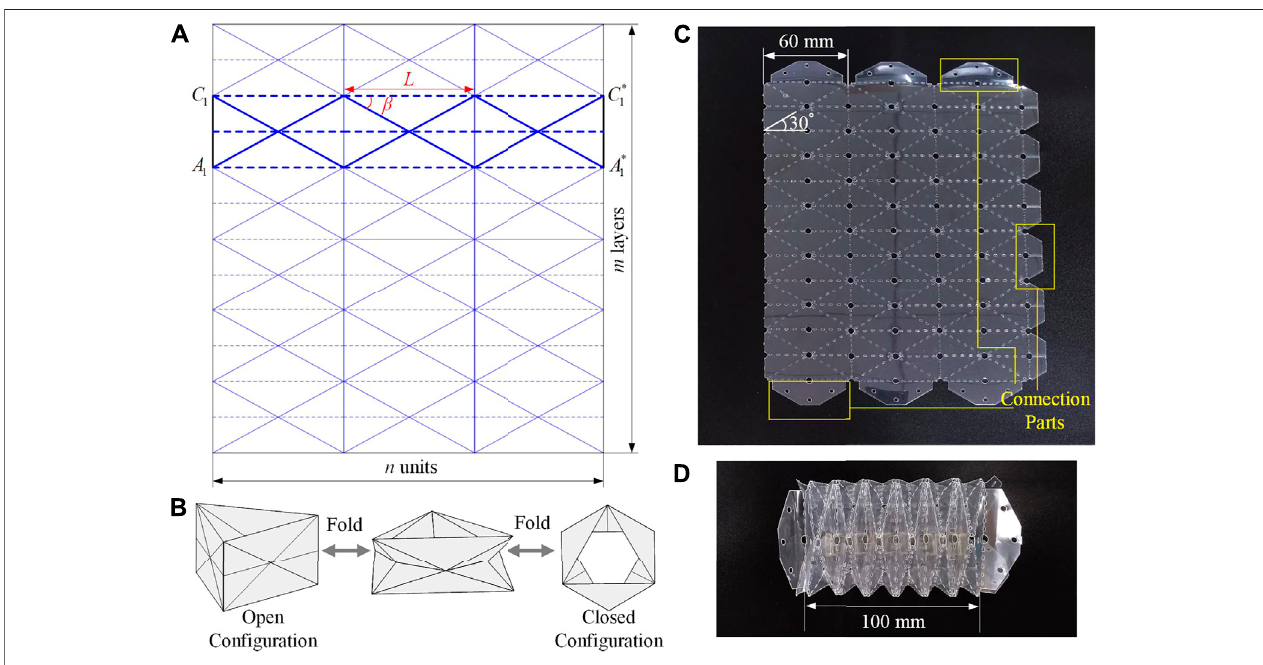
FIGURE 1 | Design and prototype of the Yoshimura-ori structure. (A) 2D crease pattern of the 3 × 6 Yoshimura-ori. By overlapping points A 1 , C 1 with A p 1 , C p 1 , a Yoshimura-ori structure can be obtained. (B) Folding motion between the open con fi guration and the closed con fi guration of a single-layer Yoshimura-ori structure. (C) The laser-machined 2D sheet of a 3 × 6 Yoshimura-ori made of PETE fi lm. (D) The obtained six-layer Yoshimura-ori structure.